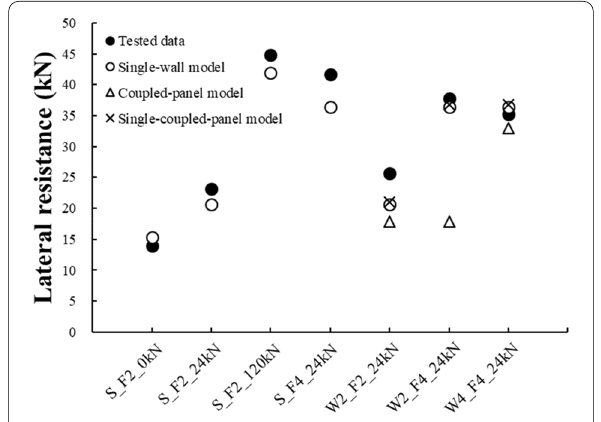
Fig. 13 Comparisons of lateral resistance of shear wall specimens